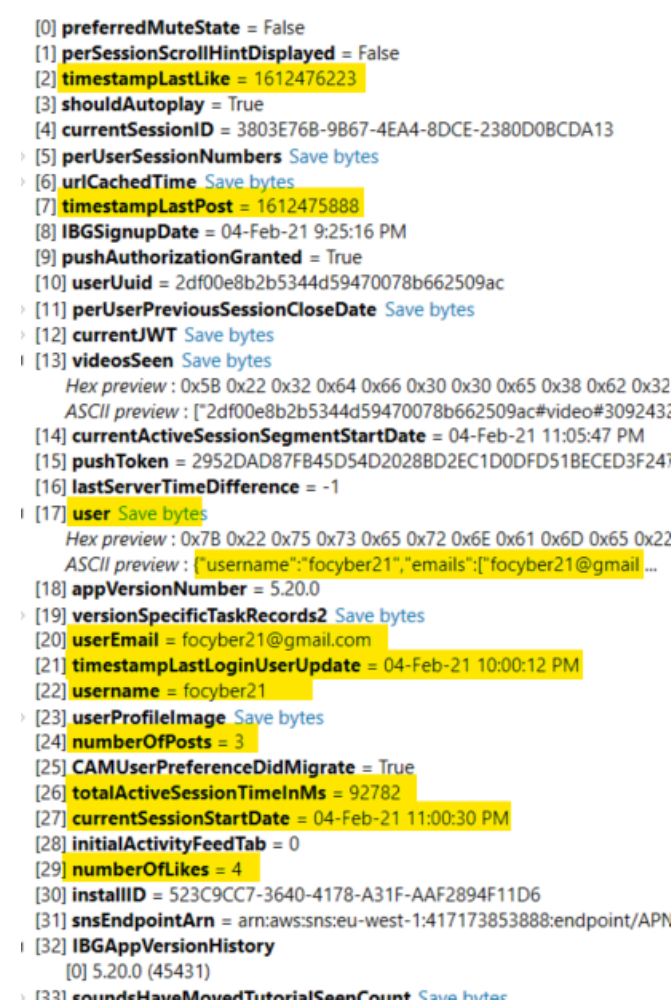
Figure 16. Events corresponding to user actions recovered from the Dubsmash iOS app.